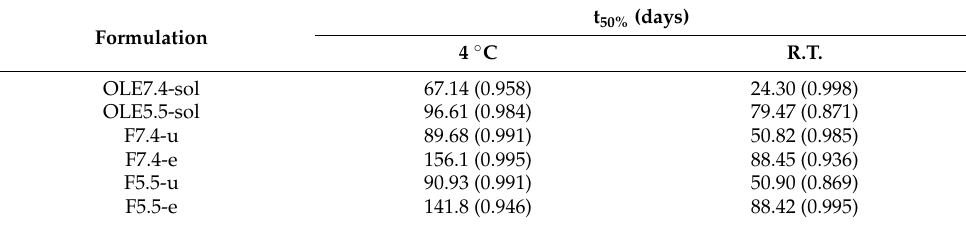
Table 3. Stability of the formulations under study, t 50% (days): in brackets the determination coeffi- cient of the curve or straight line that best fits the degradation